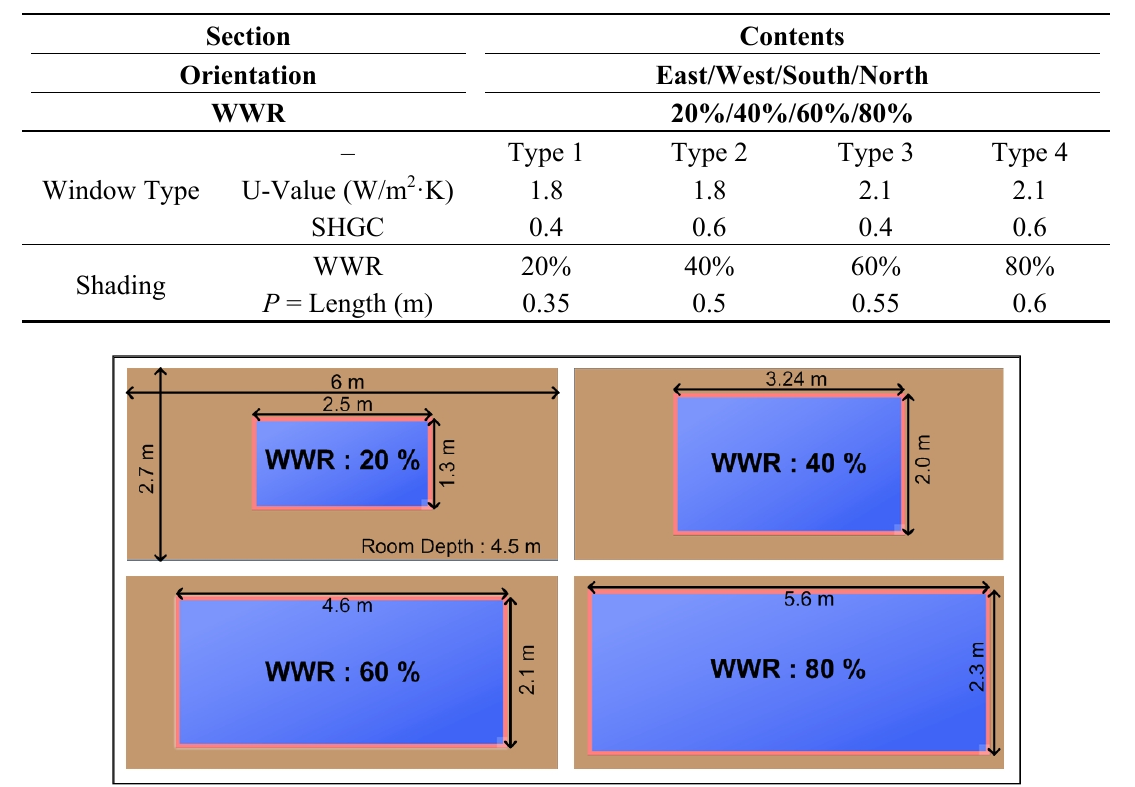
Figure 4. Simulation modeling by